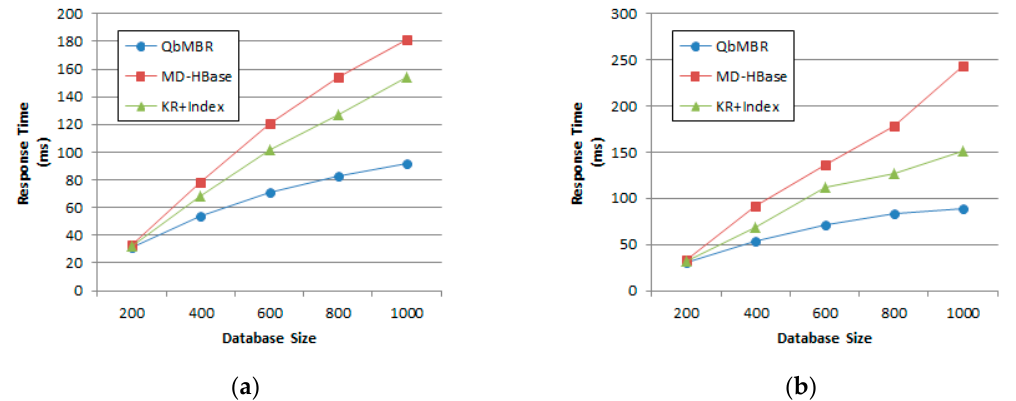
Figure 13. Effect of database size on response time: ( a ) Synthetic dataset with uniform distribution; ( b ) Synthetic dataset with normal distribution.